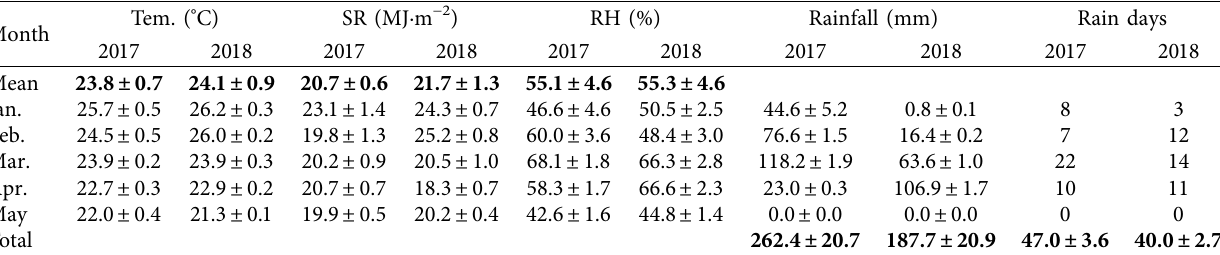
Table 3: Weather conditions during the 2017 and 2018 experimental